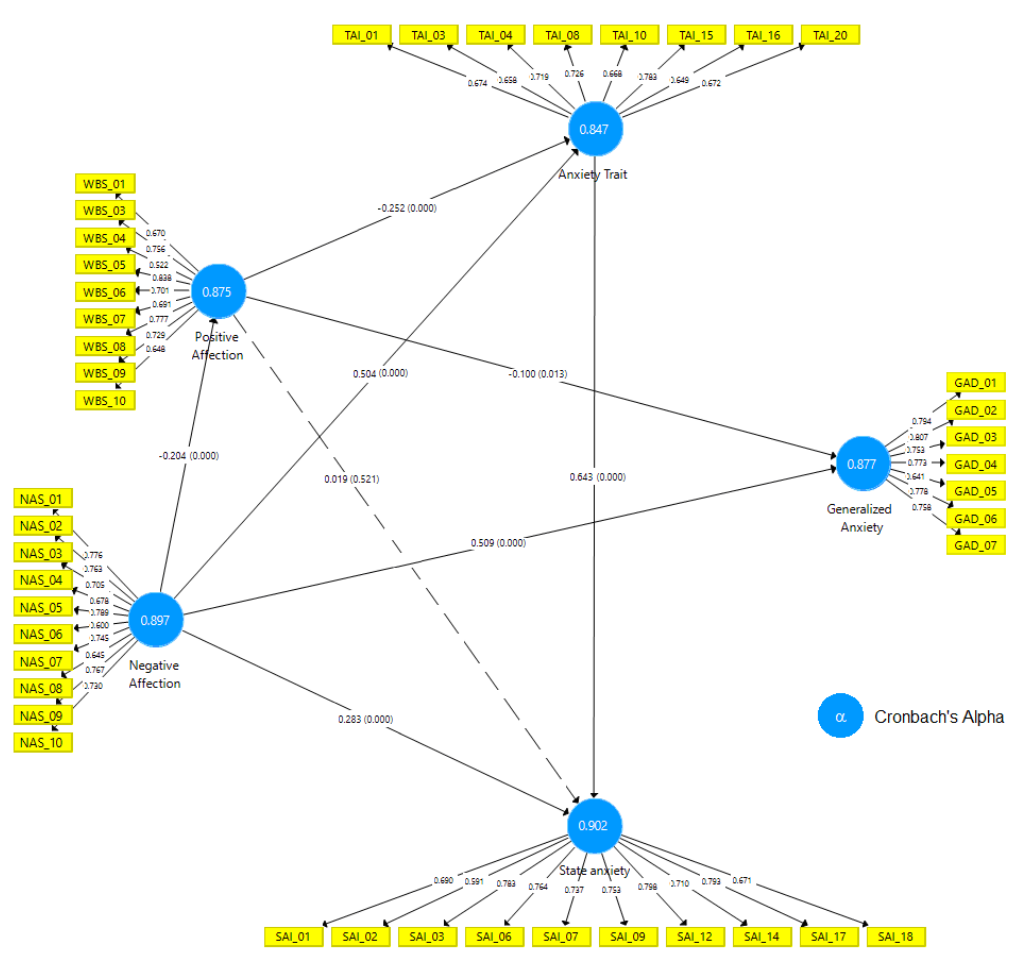
Figure 4. Final path model for the combined well-being scale / generalized anxiety / state-trait anxiety inventory (PANAS-GAD-7-STAI). Source: data research and SmartPLS ® software, v. 3.3.2 [44].